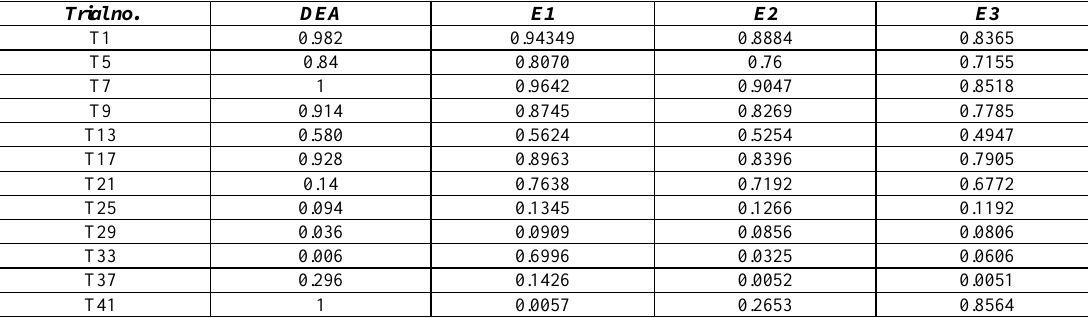
Table 2. The results of DEA and RDEA